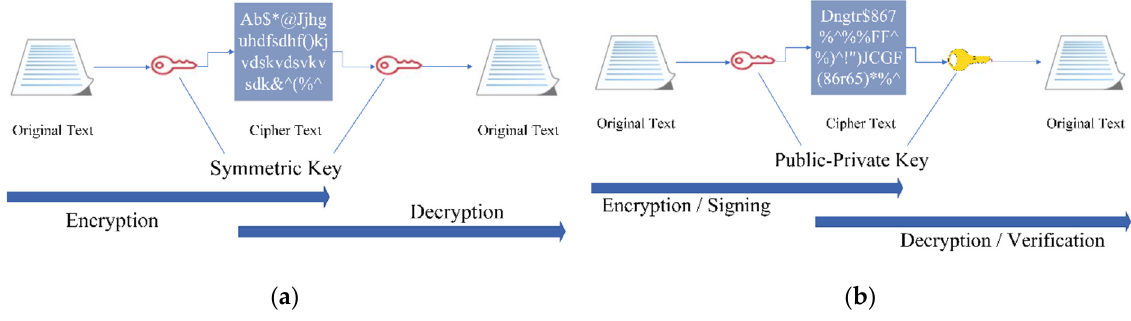
Figure 3. ( a ) Symmetric key cryptography; ( b ) Asymmetric key cryptography. There are two types of symmetric key cryptography, block cipher and stream cipher.